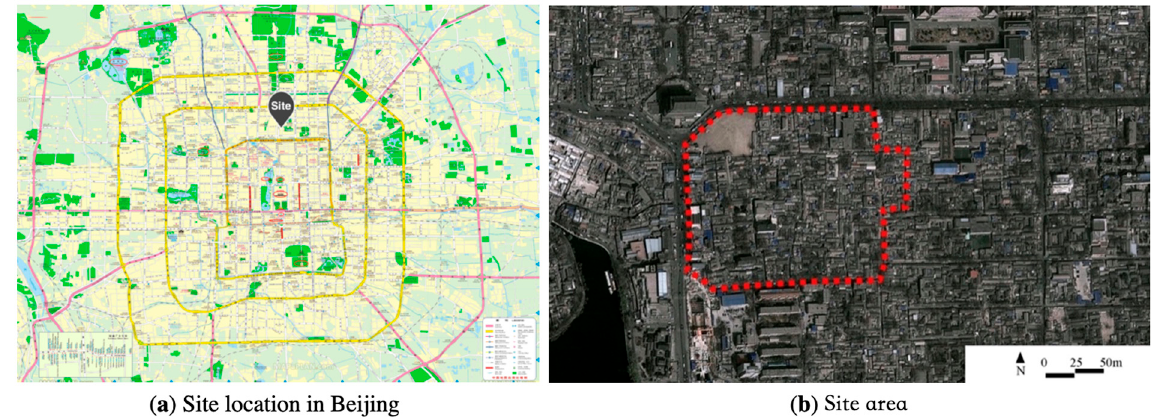
Figure 2. The location of Qian Yuan’en Si neighborhood in Beijing.